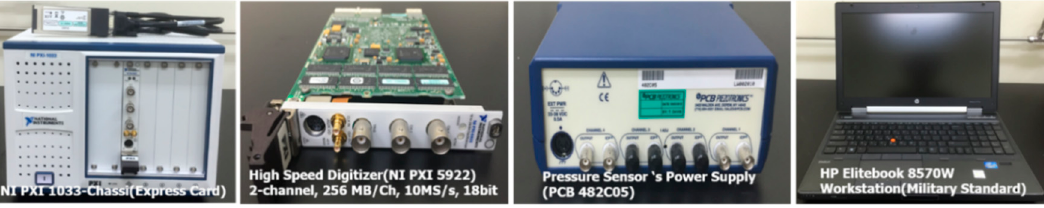
Figure 4. AIV measurement system at KRISS.